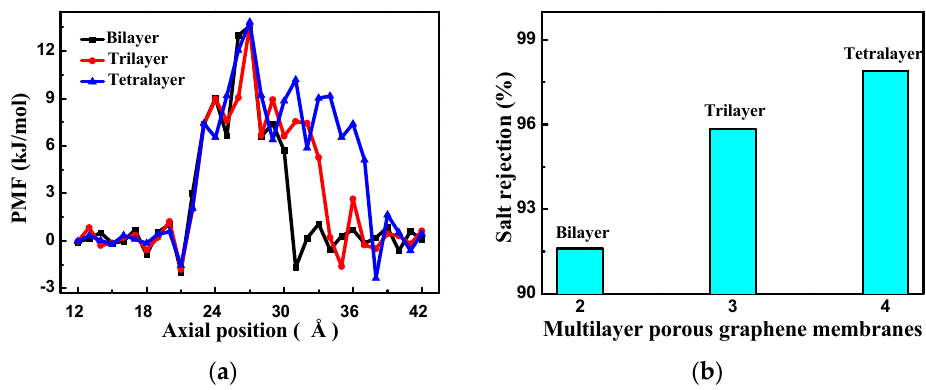
Figure 11. ( a ) The PMF of the multilayer porous graphene membranes; ( b ) salt rejection of the multilayer porous graphene membranes.